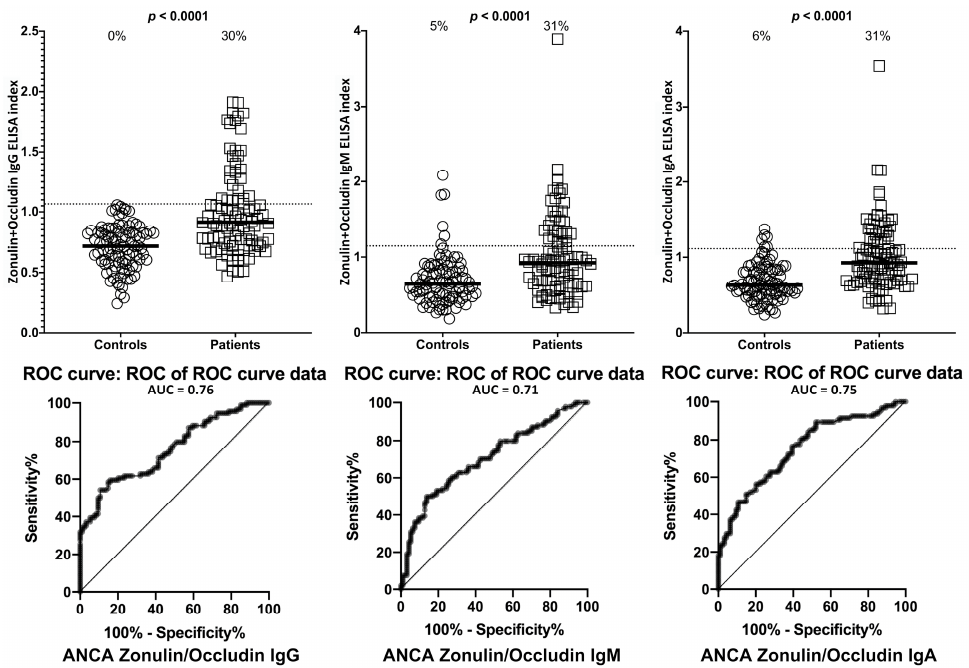
Figure 6. Percentage of elevation of IgG, IgM, and IgA antibodies against lipopolysaccharides (LPS) in 94 patients positive for ANCA and in 94 healthy controls. Dotted lines indicate the cutoff for positivity used in each assay, as calculated by ROC analysis. The percentage of elevation is indicated on top of each distribution, while bars indicate the corresponding median. The AUC for LPS IgG was 0.87, 0.76 for LPS IgM, and 0.77 for LPS IgA.